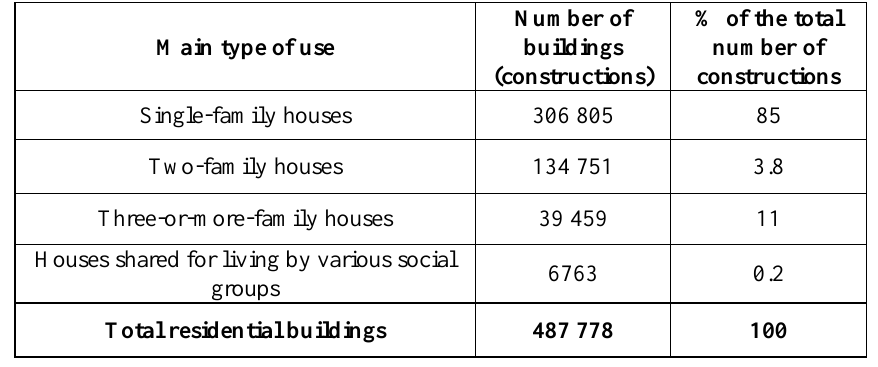
Fig. 3. The number of co-operative societies of apartment owners in Latvia [the authors’ calculations]. Table 1. The Division of Residential Buildings by Main Type of Use in Latvia, as of 1 January 2016 (State Land Service,